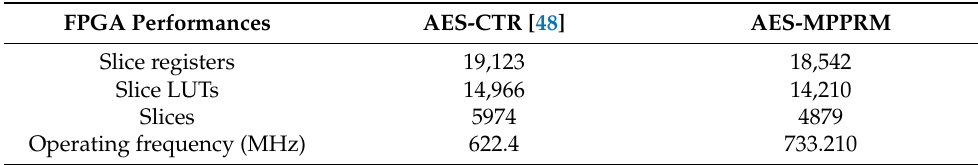
Table 8. Comparison of AES-MPPRM and AES-CTR for Virtex 5 FPGA.